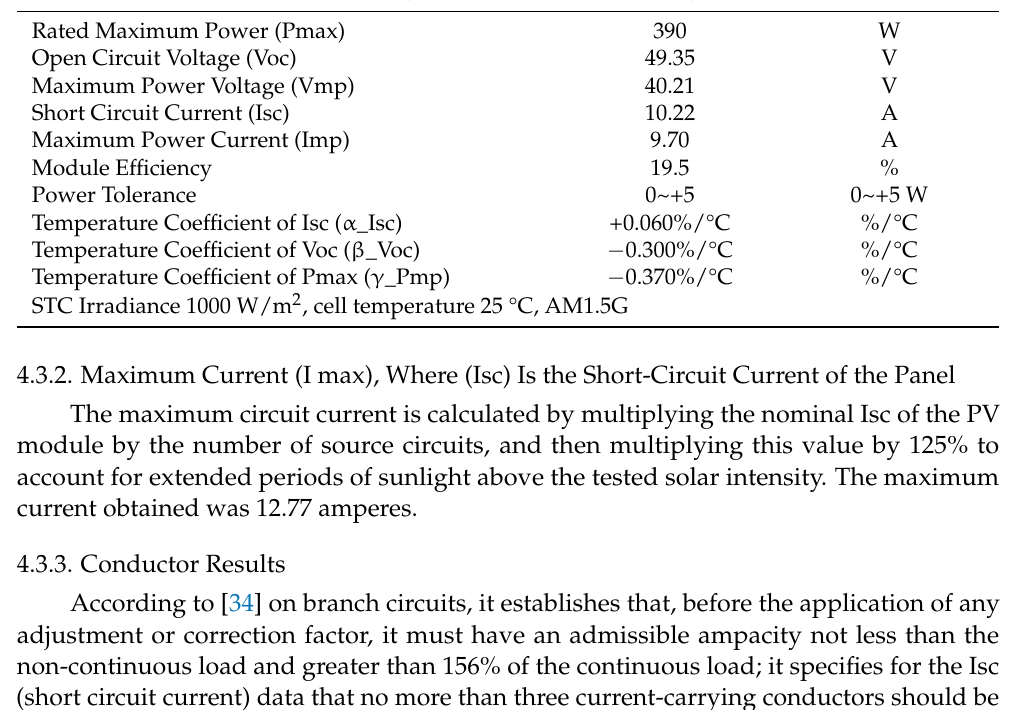
Table 4. Specifications of the JA Solar JAM72S09-390/PR 390 Wp panels [79]. Electrical Parameters AT STC (At Standard Test